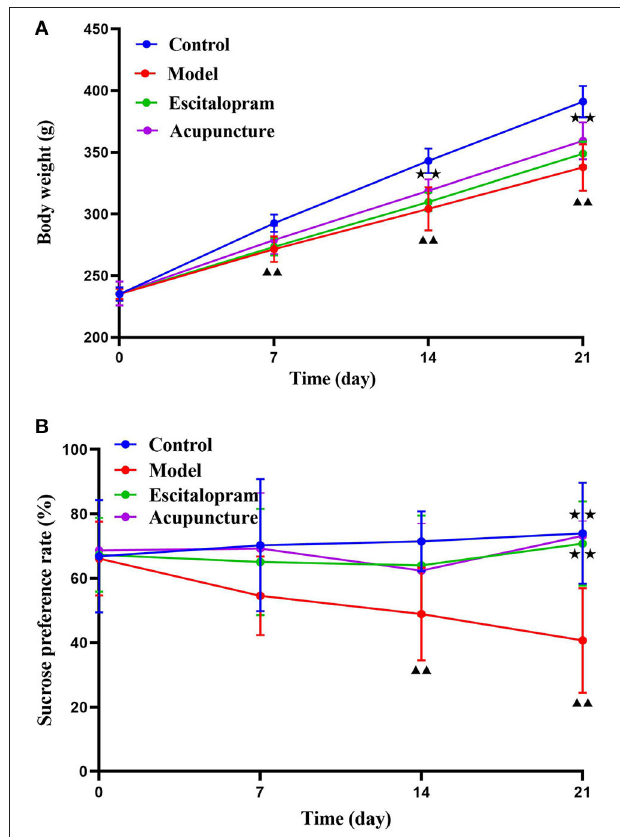
FIGURE 2 | Effects of acupuncture on the CRS-induced depressive-like behaviors in rats. (A) Effect of acupuncture on the changes of body weight of CRS rats; NN P < 0.01, compared with control group; ⋆⋆ P < 0.05, compared with model group. (B) Effect of acupuncture on the changes of sucrose preference rate of CRS rats. NN P < 0.01, compared with control group; ⋆⋆ P < 0.01, compared with model group. Repeated ANOVA followed by LSD’s post-hoc